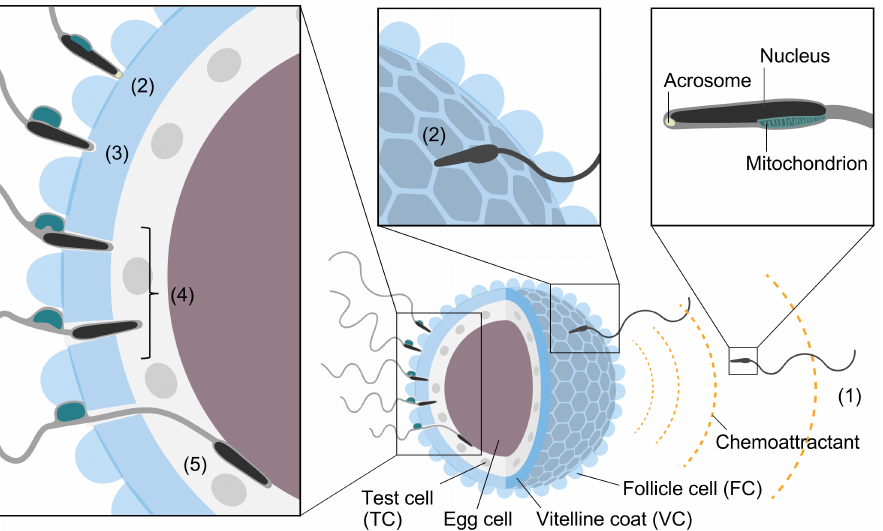
Figure 1. Fertilization processes of the ascidian Halocynthia roretzi . Generally, fertilization processes consist of 5 steps: (1) sperm activation and chemoattraction; (2) sperm binding to the egg coat (species and self/nonself recognition); (3) sperm reaction (sperm activation and AR); (4) sperm penetration of the egg coat (vitelline coat (VC)) with the aid of lysin; and (5) gamete fusion. In ascidians, upon sperm binding to the VC, the sperm undergoes a sperm reaction, which is characterized by vigorous movement on the VC and mitochondrial swelling and sliding through the tail. In H . roretzi , a self/nonself-gamete-recognizable sperm receptor on the surface of the VC, called VC70, is exposed between FCs. It is proposed that the sperm head and tail are inserted into the perivitelline space by the driving force of the sliding of the mitochondrion, whose plasma membrane is attached to the VC. The sperm (pro)acrosin located at the surface of the mitochondrion may be involved in binding to the VC. In this process, the ubiquitin–proteasome system is partially released or exposed on the sperm surface ubiquitinates and degrades VC70, which is necessary for sperm penetration of the VC. Sperm astacin-like metalloprotease is also involved in this